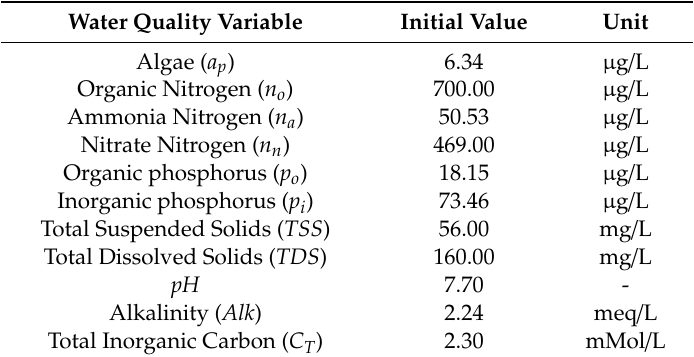
Table 2. Initial concentration of the studied water quality